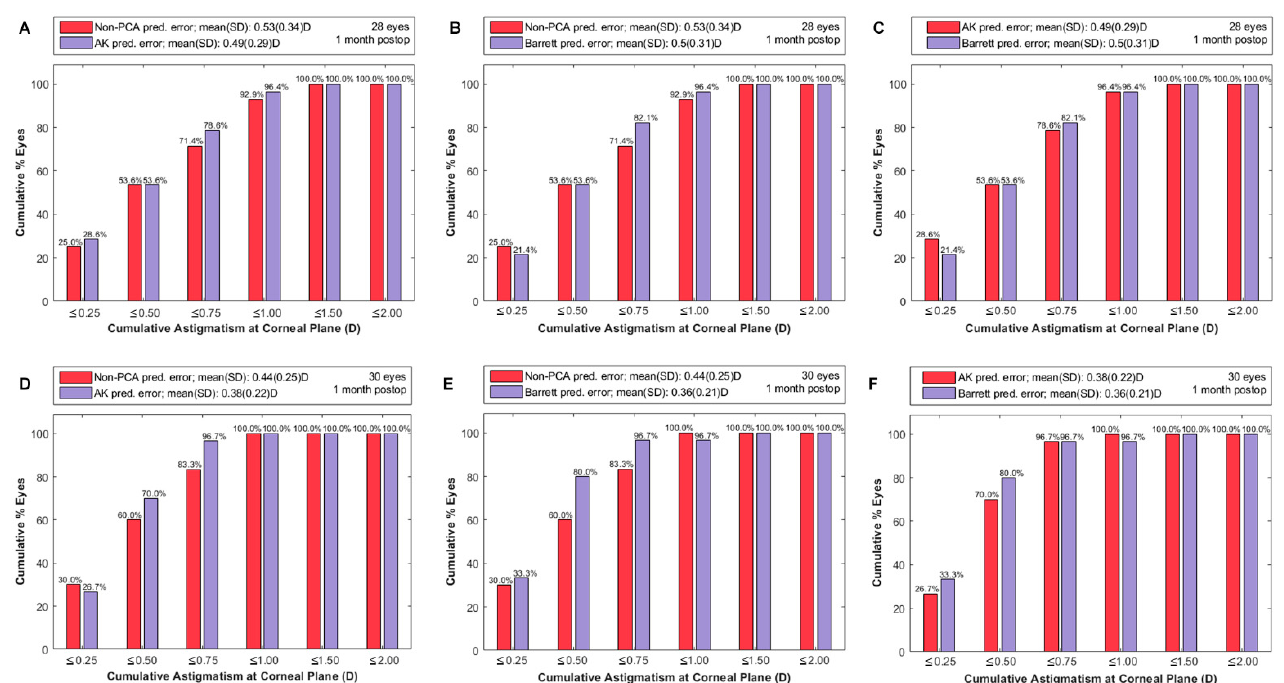
Figure 2. Cumulated percentage of eyes below or equal to a particular value for the astigmatism prediction error in the Phaco group without considering posterior corneal astigmatism [non-PCA] versus Abulafia-Koch [AK] estimation ( A ), non-PCA versus Barrett estimation ( B ) and AK versus Barrett ( C ). Same calculations for the Femto group in non-PCA vs. AK ( D ), non-PCA vs. Barrett ( E ) and AK vs. Barrett ( F ).